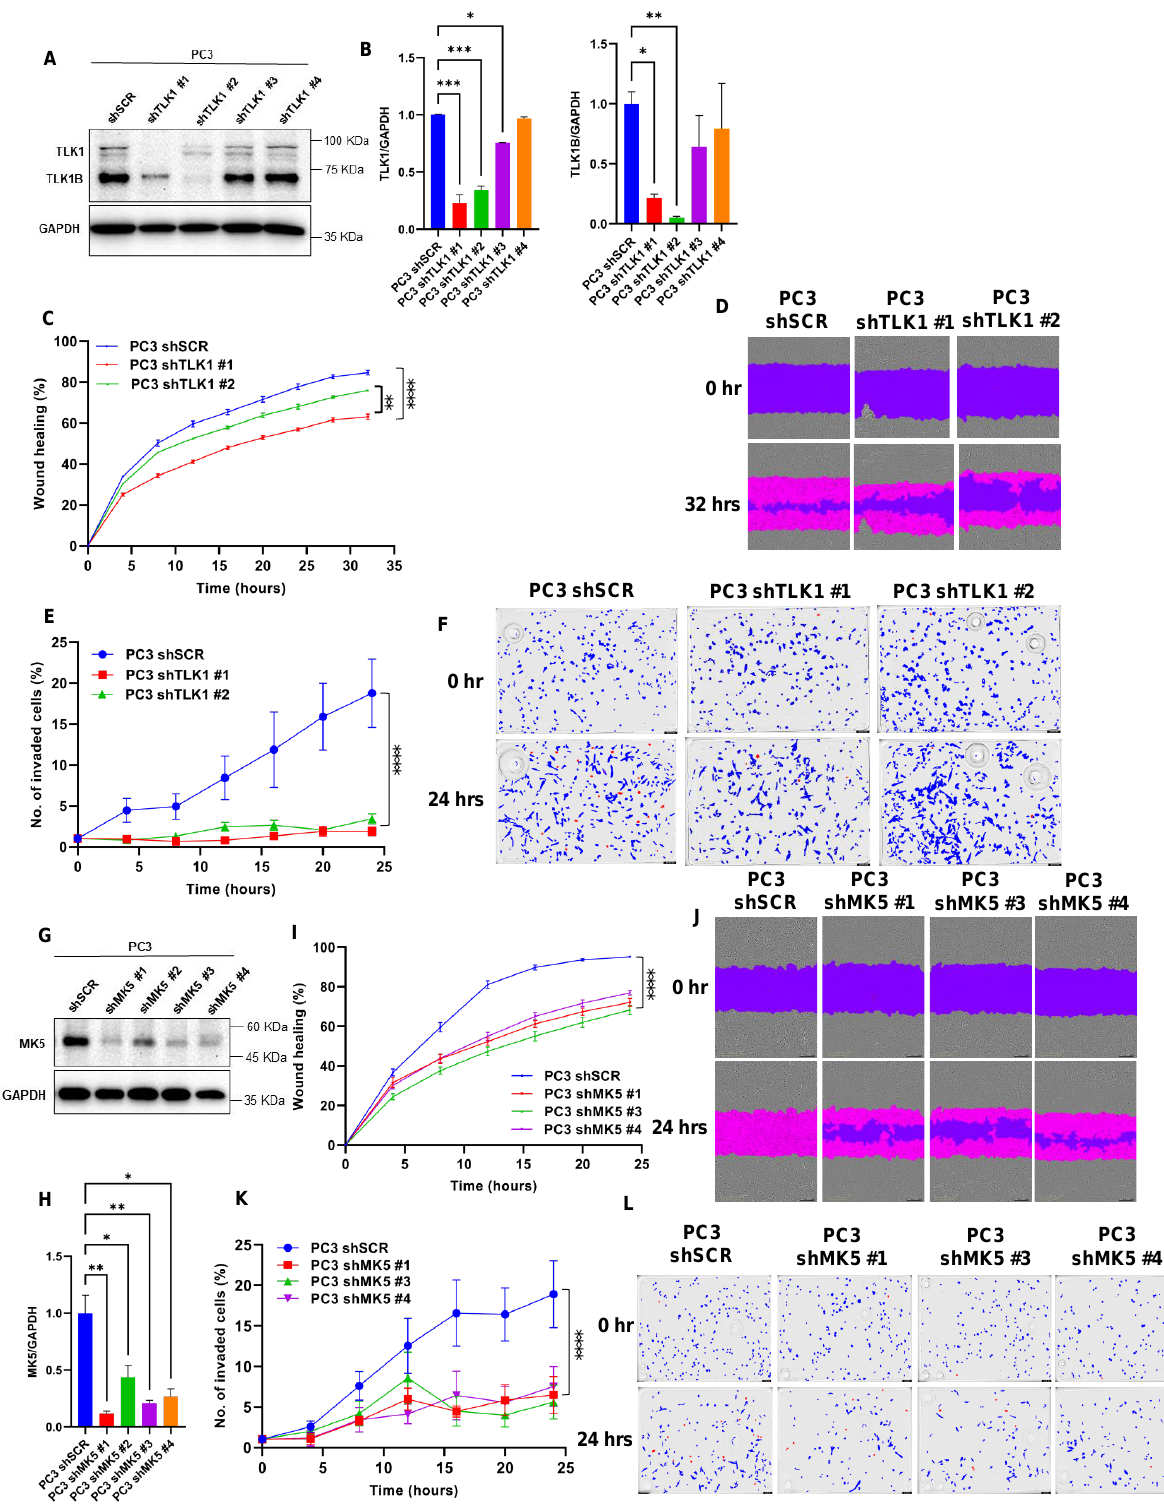
Figure 1. Genetic depletion of TLK1 or MK5 leads to reduced motility and invasion of PC3 cells. ( A ) Stable knocked down of TLK1 and TLK1B upon either scrambled (shSCR) or four different TLK1-specific shRNA treatments in PC3 cells transduced with lentivirus. Image is the representation of two independent experiments ( n = 2). ( B ) Quantification of TLK1 (left panel) and TLK1B (right panel) level upon TLK1 knockdown normalized to GAPDH in PC3 cells. ( C , I ) Scratch wound